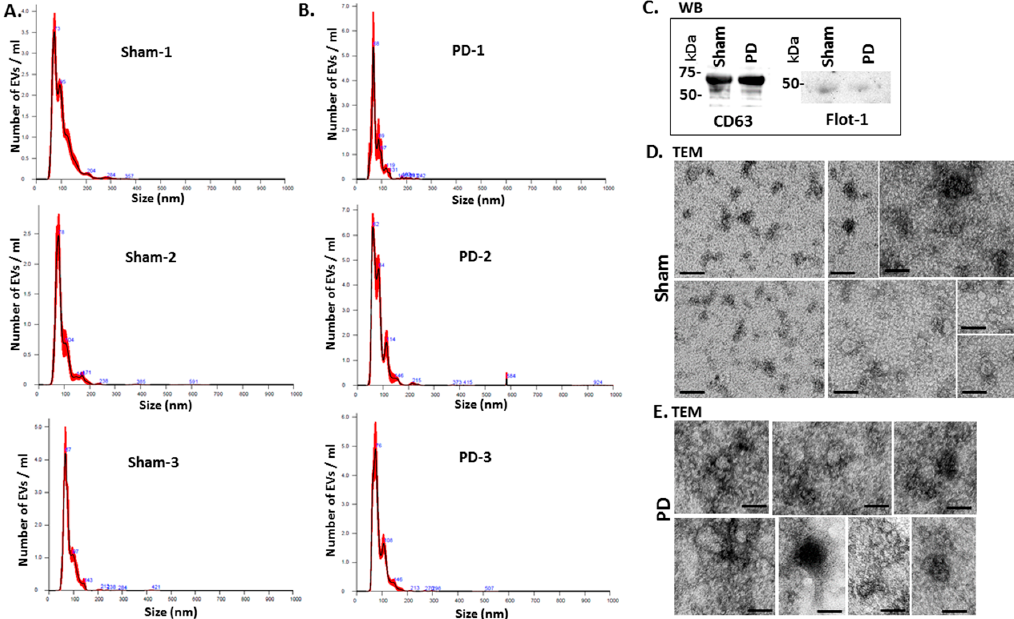
Figure 2. EV characterisation from rat plasma. ( A ) Representative Nanosight graphs showing nanoparticle tracking analysis (NTA) analysis of plasma EV profiles from sham-treated rats (Sham; n = 3). ( B ) Representative Nanosight graphs showing NTA analysis of plasma EV profiles from the pre-motor PD rat models (PD; n = 3). ( C ) Western blotting (WB) confirms that rat plasma-EVs are positive for the EV-specific markers CD63 and flotillin-1 (Flot-1); the molecular weight standard is indicated in kilo Daltons (kDa). ( D , E ) Transmission electron microscopy (TEM) images showing EVs isolated from sham ( D ) and pre-motor PD model (PD; ( E )) rat plasma, revealing typical EV morphology; composite images are shown and the scale bar represents 50 nm in all images. In the NTA curves the black line represents the mean of the 5 repetitive readings per individual sample and the red line represents standard error ( +/ − ) between those same 5 readings per sample. Each treatment group was measured in 3 biological replicates (sham; PD = pre-motor PD